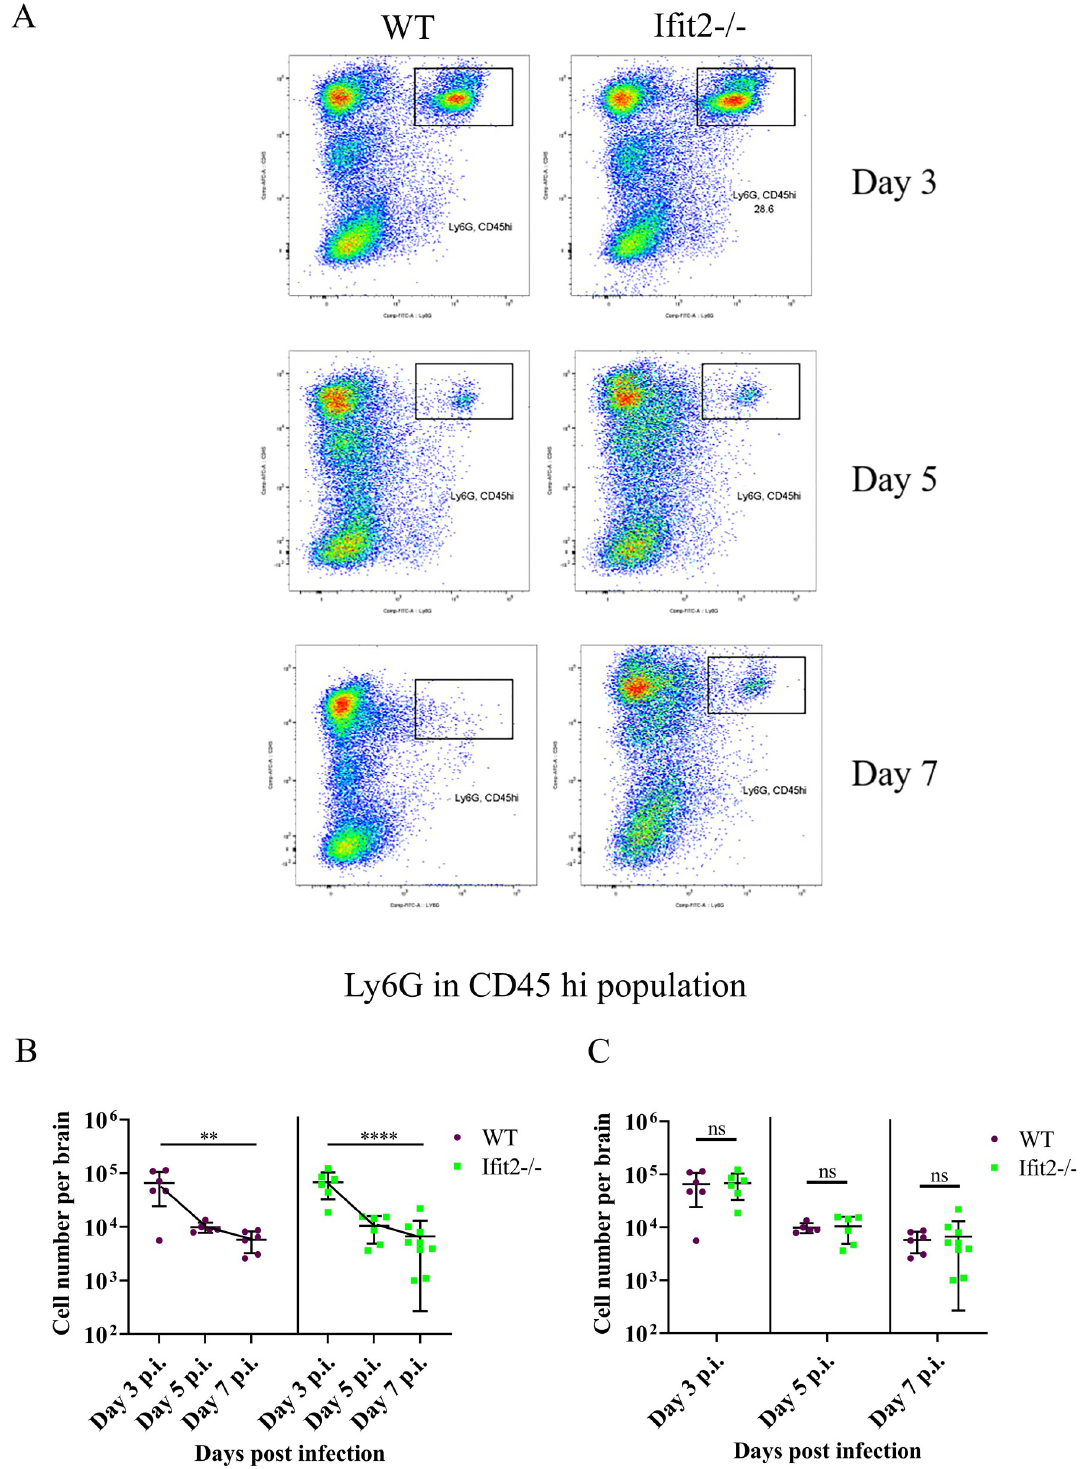
Fig 8. Ifit2 deficiency does not alter neutrophil migration into the CNS. Cell suspensions from brains of infected WT and Ifit2 -/- mice were analysed as described in Fig 6 by flow cytometry following staining for CD45 and the neutrophil marker Ly6G. Panel A shows representative flow cytometry plots at days 3,5,and 7 p.i. Absolute numbers of Ly6G + CD45 hi cells are graphically represented across timepoints for each group (Panel B) and between WT and Ifit2 -/- groups for day 3 p.i., 5 p.i., and day 7 p.i. (Panel C) to better